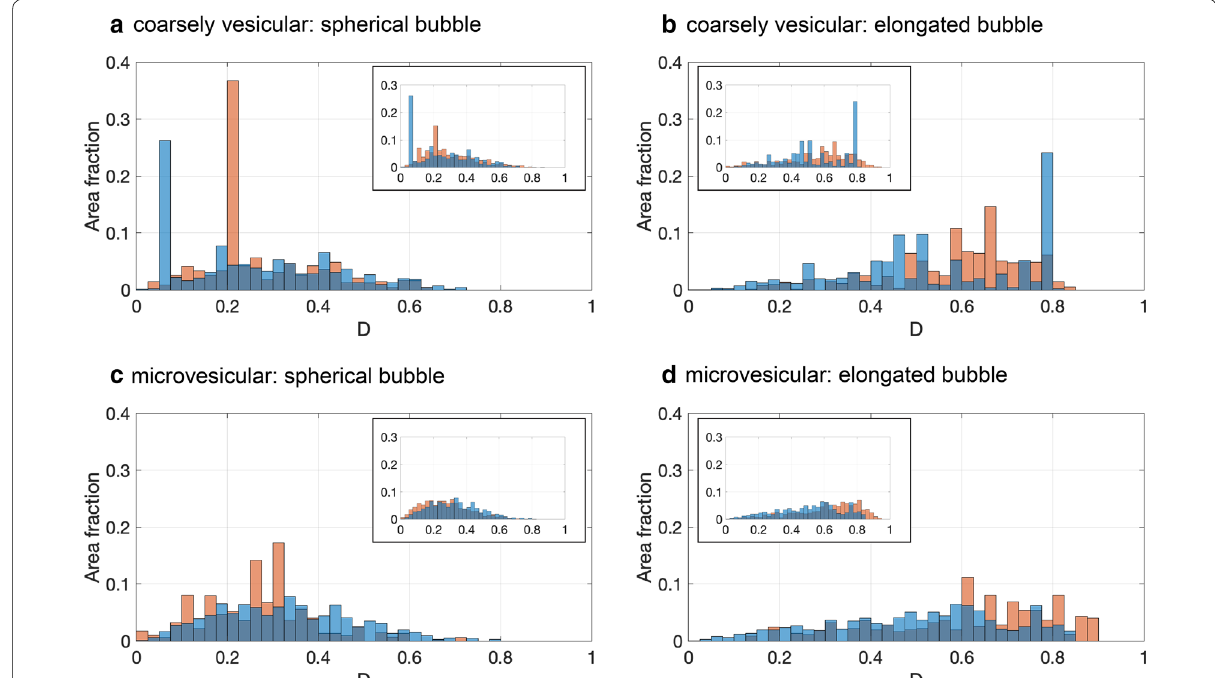
Fig. 6 Histograms of bubble deformation degree. Histograms of bubble deformation degree versus area fraction obtained with the DSM-LaRI (blue) and the SEM (red). The mainframes include only bubbles of equivalent radii larger than 0.05 mm , while the inset graphs show the area fraction distribution of all the bubbles captured by the SEM. a Sample 08_07. b Sample 08_18. c Sample 10_26. d Sample